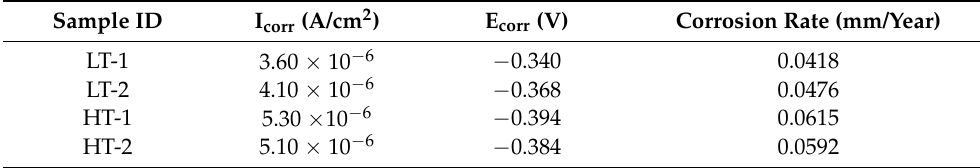
Table 7. Corrosion parameters of ballistic steel samples obtained from Tafel